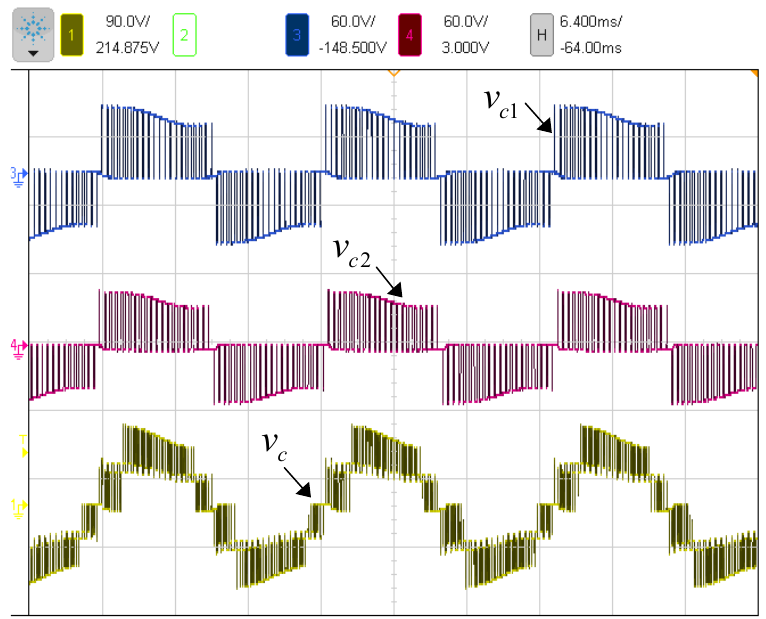
Figure 13. Steady-state experimental results at converter-side variables: Output voltage for each cell and total output voltage.